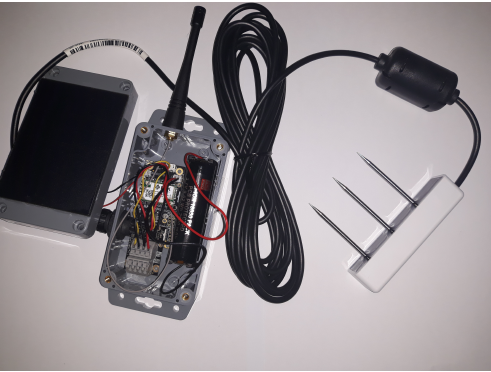
Figure 4. LoRaWAN module with TEROS 12 sensor from Meter Group.